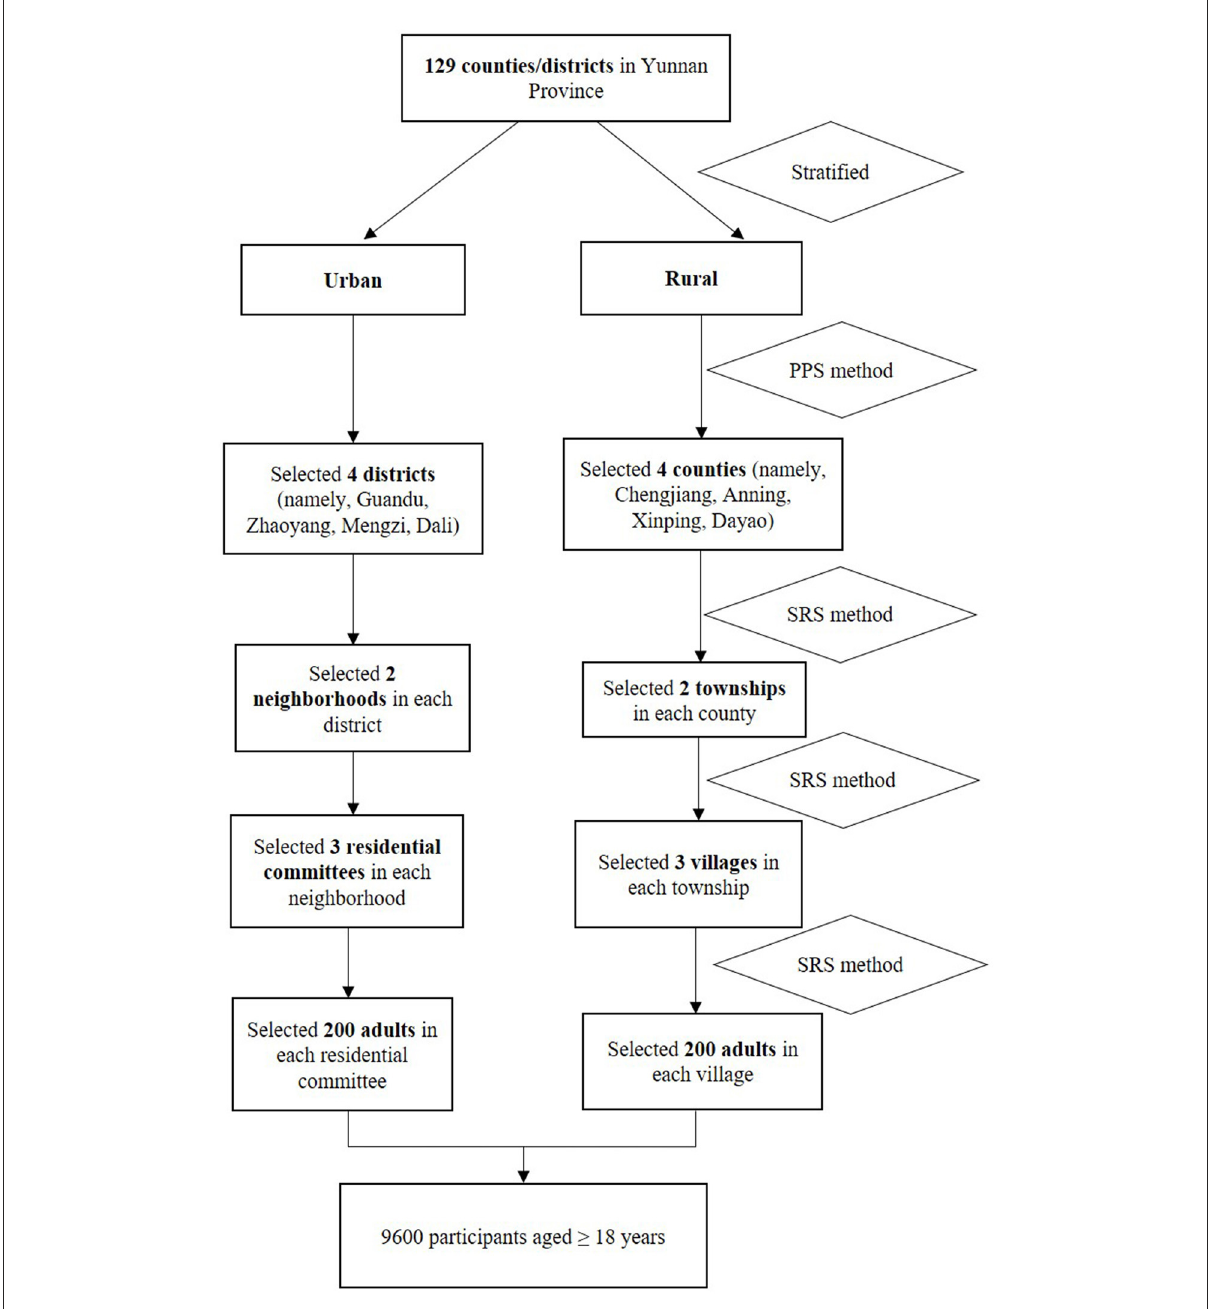
FIGURE1 The Hypertension survey procedure of sampling. PPS, probability proportional to size; SRS, simple random